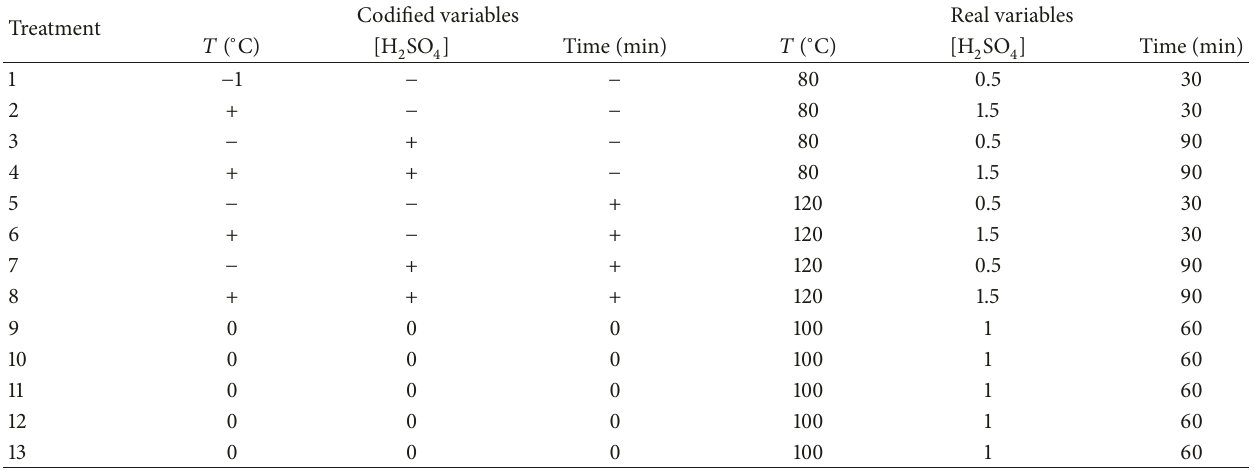
Table 1: Factorial experimental design (2 3 ), including independent variables (temperature, H 2 SO 4 concentration, and time).